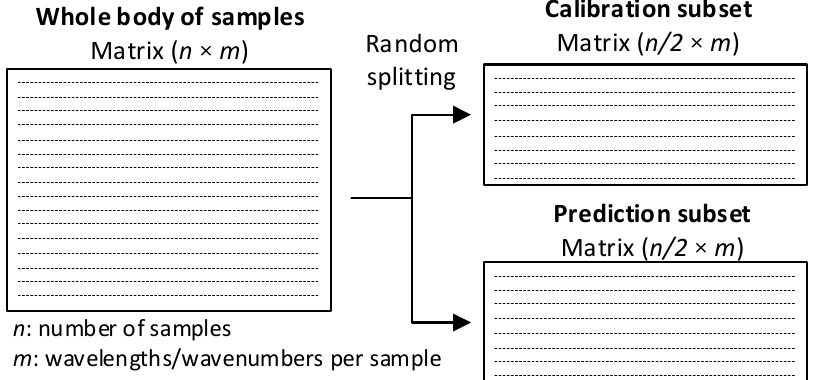
Figure 2. Entire body of samples divided into calibration and prediction sets.